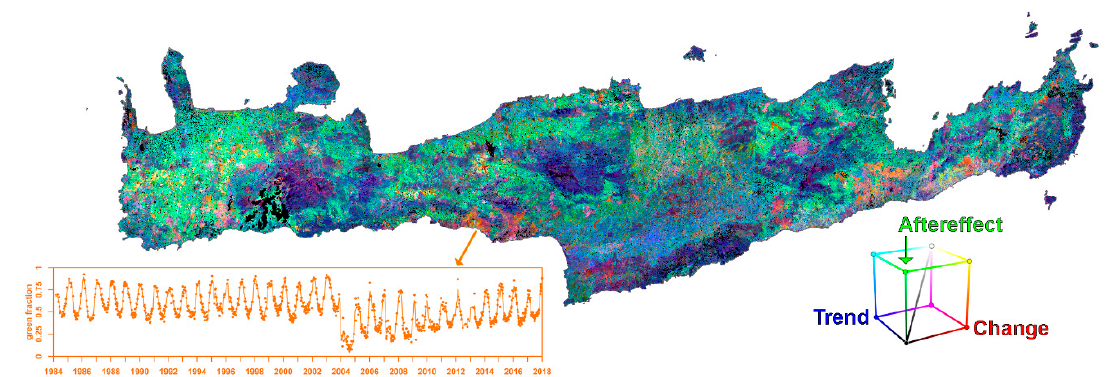
Figure 11. Land surface phenology-based trend and change analysis for Crete, Greece. The change, aftereffect, trend (CAT) transformation shows both long-term (30+ years) gradual, and abrupt changes. The CAT transform was applied to the annual value of base-level phenometric time series, which was itself derived by inferring land surface phenology metrics from dense time series of green vegetation abundance, derived from spectral mixture analysis (SMA) of Landsat ARD.